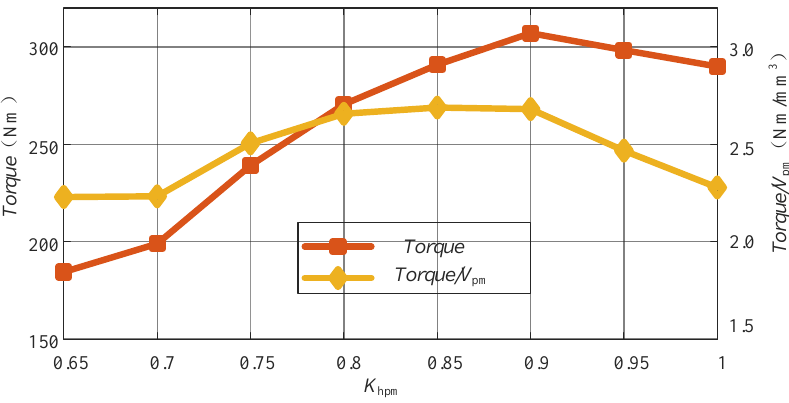
Figure 4. This is a figure. Schemes follow the same formatting.